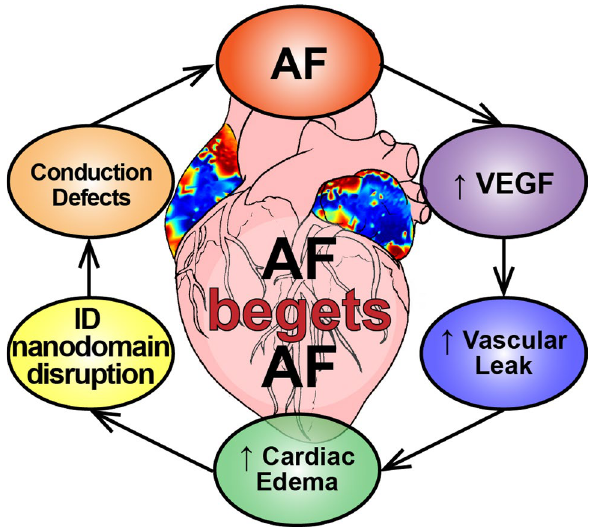
Figure 10. Proposed mechanism for the genesis and progression of AF. Elevated VEGF levels in AF patients increase vascular leak, in turn promoting cardiac edema. The resulting disruption of Na V 1.5-rich ID nanodomains slows atrial conduction, thereby providing a substrate for further atrial